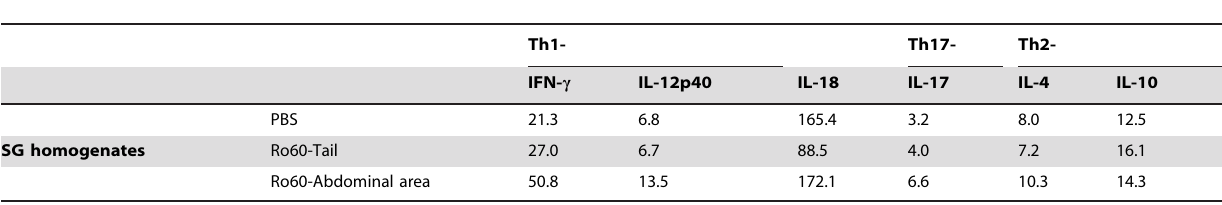
Table 2. Salivary gland cytokines in Ro60-immunized Balb/c mice.